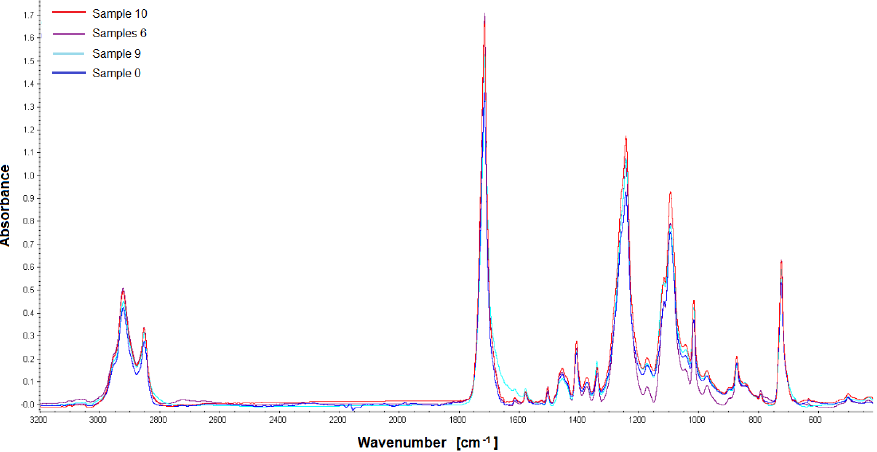
Figure 9. FTIR spectra of the studied PET-DLA 65 copolymers: sample 0-not implanted, sample 17, 19, 21 after 12-week implantation period.